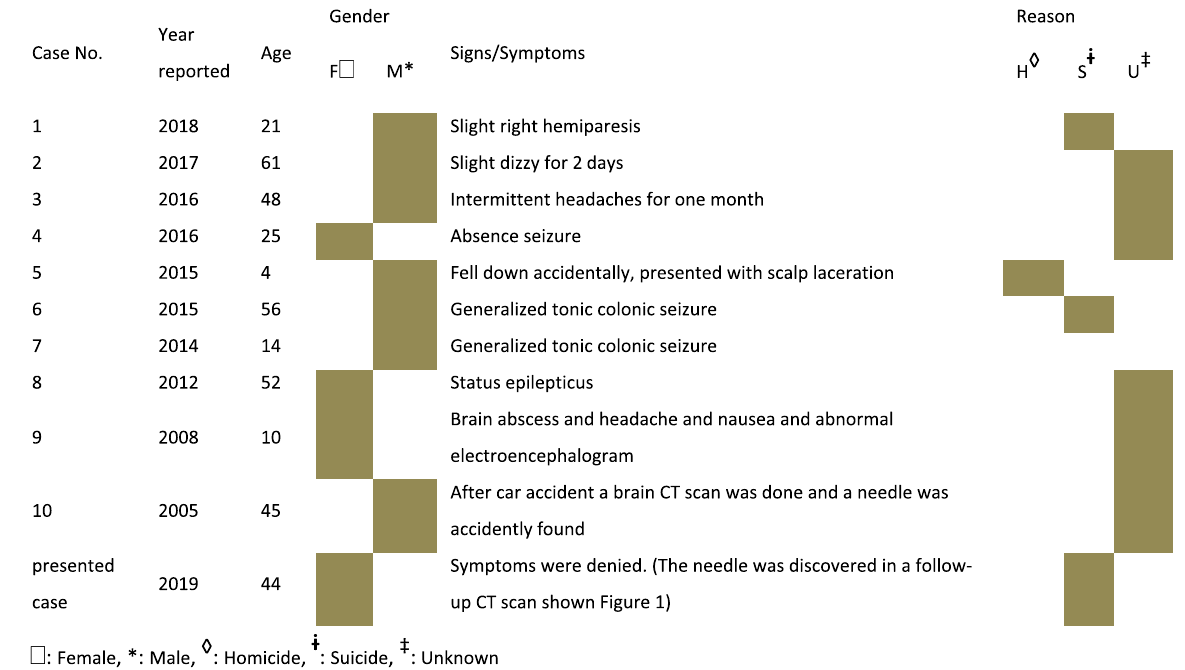
Table 1 Brief review of intercranial foreign body reported